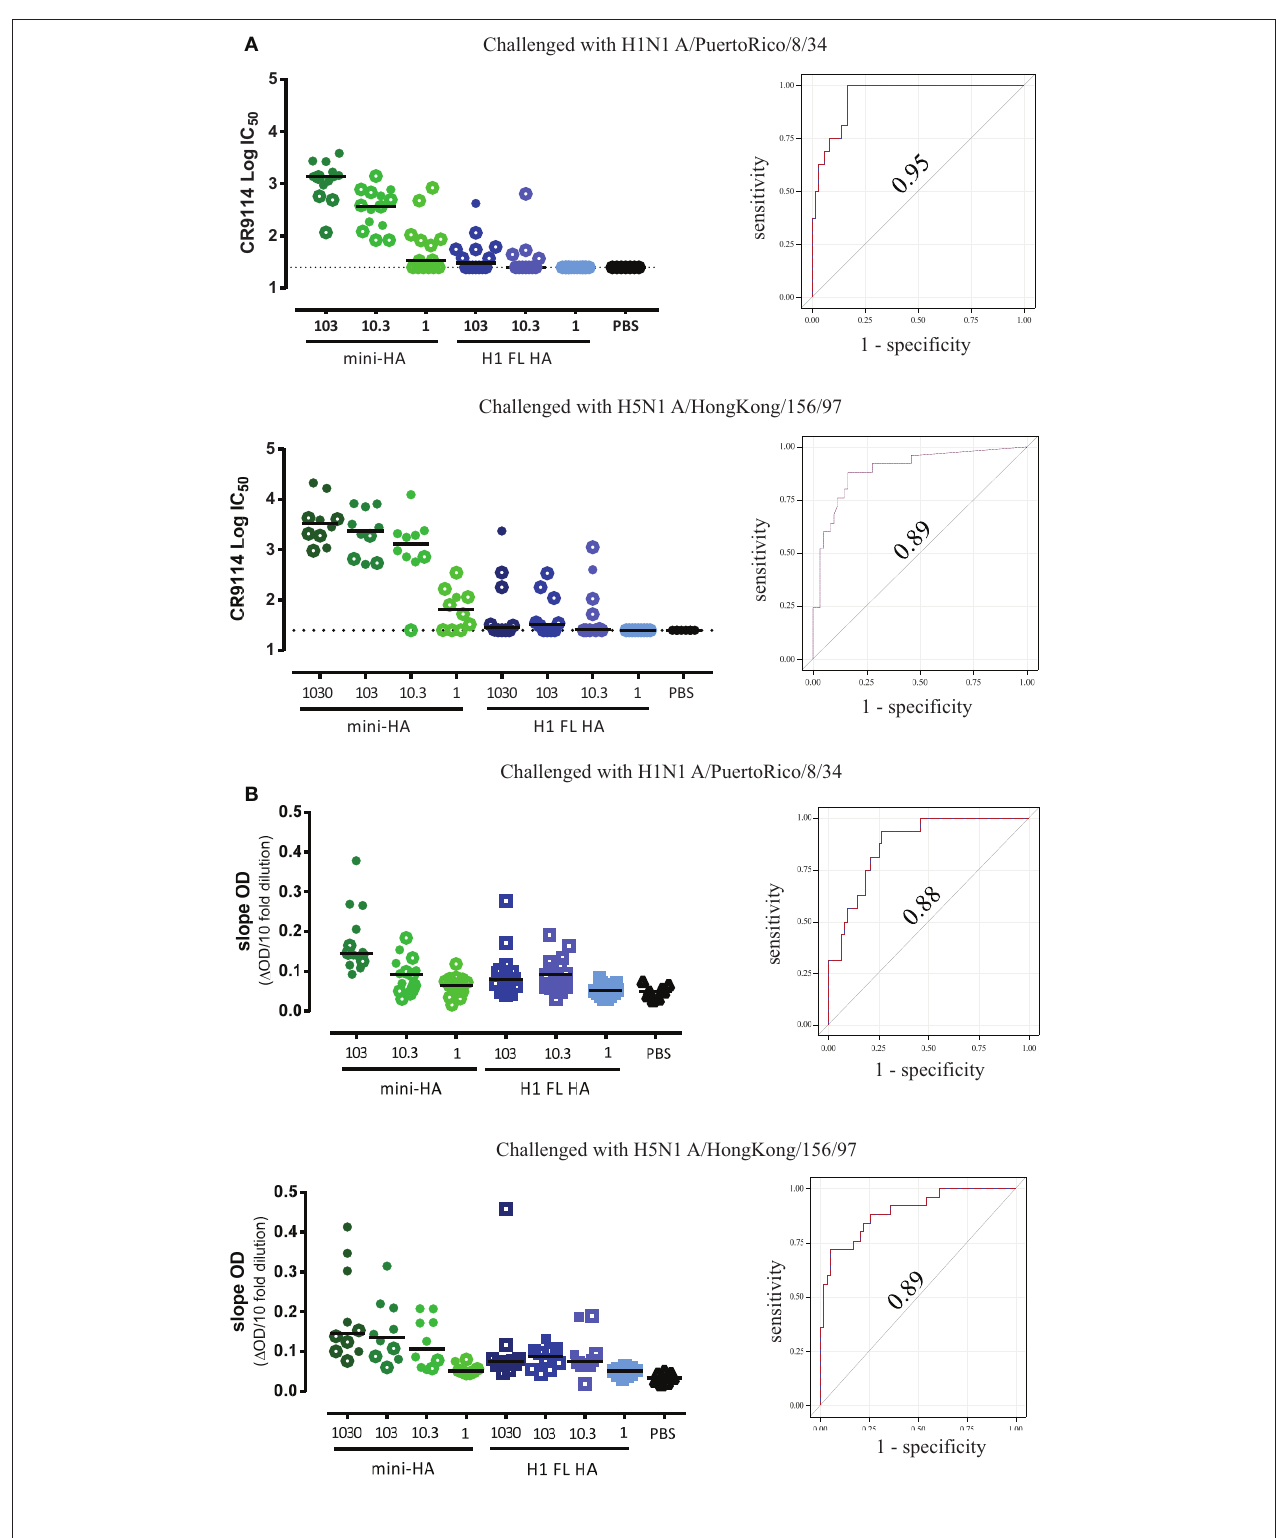
FIGURE 5 | (A) . bnAb CR9114 competing antibody titers correlate with survival group 1 mini-HA used as antigen. Serum taken one day prior to challenge was tested for competition with bnAb CR9114, using mini-HA UFV4900 as antigen (left). Open symbols represent mice which did not survive subsequent challenge. Solid